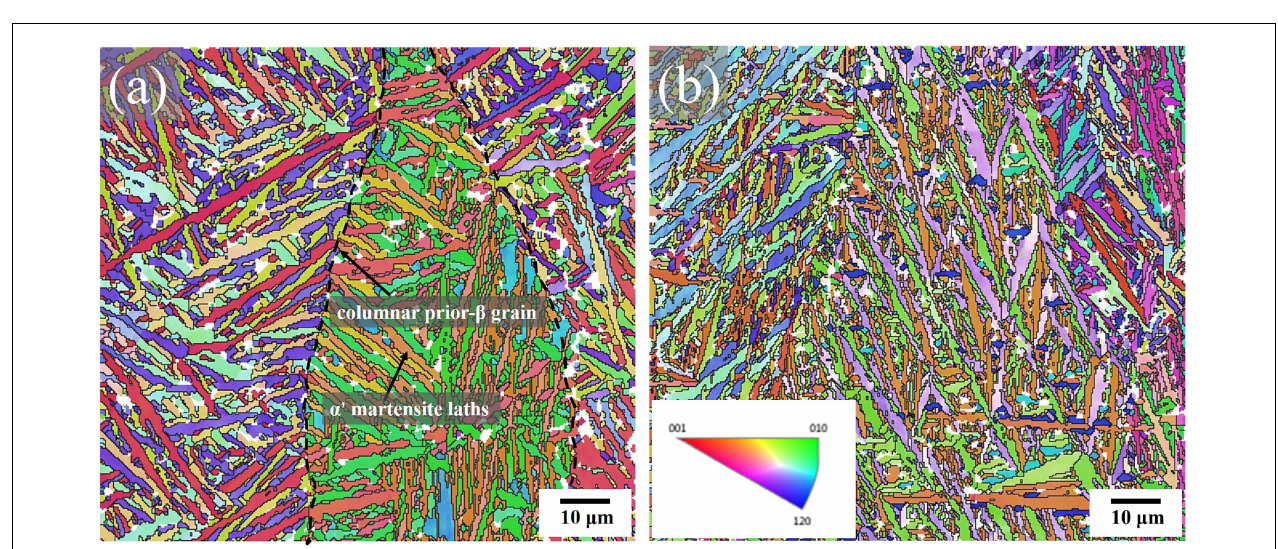
FIGURE 4 | EBSD microscopy of blade, (a) at the leading edge, (b) at the trailing edge.